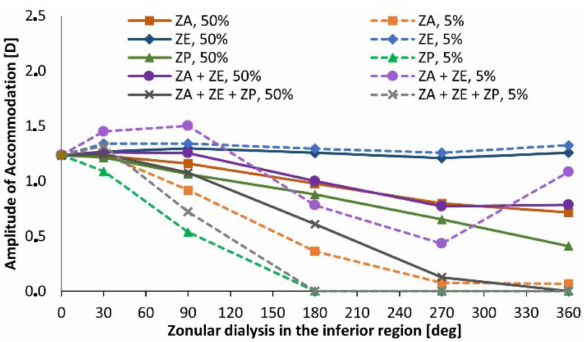
Figure 4. Amplitude of accommodation for pseudoexfoliative models with superior